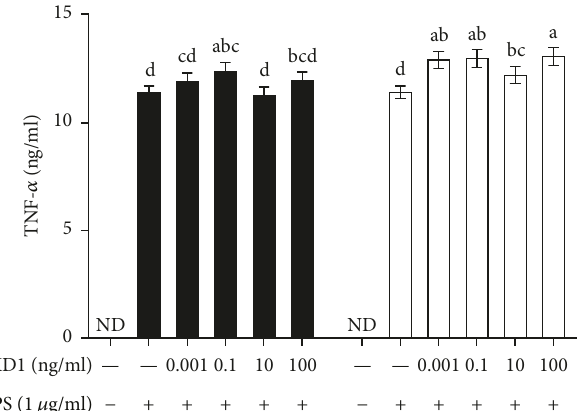
Figure 2: PKD1 stimulate secretion of TNF- 𝛼 from LPS-stimulated RAW264.7 cells. Protein kinase D1 (PKD1; 0.001, 0.1, 10, 100ng/ml) was administered apically to Caco-2 cells in co-culture with RAW264.7 cells. An inflammatory response was induced in RAW264.7 cells with 1 𝜇 g/ml lipopolysaccharide (LPS, E. coli : O127). Effects of PKD1 on secretion of TNF- 𝛼 from RAW264.7 cells were evaluated in two different situations: ( ◼ ) LPS was administered to RAW264.7 cells for 3 h, followed by PKD1 to Caco-2 cells for 3 h to investigate whether PKD1 can ameliorate an already induced inflammation. ( ◻ ) PKD1 was administered to Caco-2 cells for 3 h at which point RAW264.7 cells werestimulatedwithLPSfor6 htoevaluatewhetherPKD1cansuppressinflammationinitiation. TNF- 𝛼 levelincontrols(noLPSstimulation) was undetectable (ND). Data are presented as means ± SEM ( 𝑛 = 3 ). Significant differences ( 𝑃 < 0.05 ) within concentrations of PKD1 are indicated by the lowercase